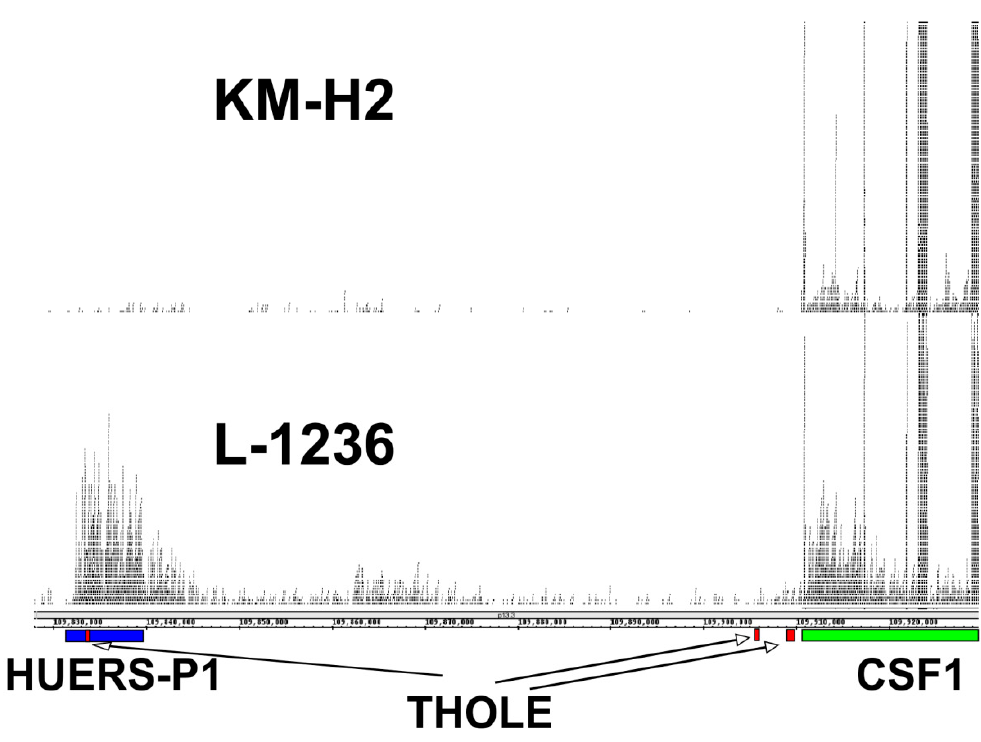
Figure 3. Comparison of THOLE and CSF1 transcription in HL cell lines L-1236 and KM-H2. Publicly available RNA-seq reads from HL cell lines L-1236 (SRR7890158) and KM-H2 (SRR8615908) were mapped to the human reference genome (hg38) by using Bowtie2. Mapped reads in the genomic region between the THOLE-associated HUERS-P1/LTR8 and the CSF1 locus on chromosome 1 were visualized in Integrated Genome Browser. The positions of HUERS-P1 (blue), THOLE exons (red), and the CSF1 gene (green) are indicated.